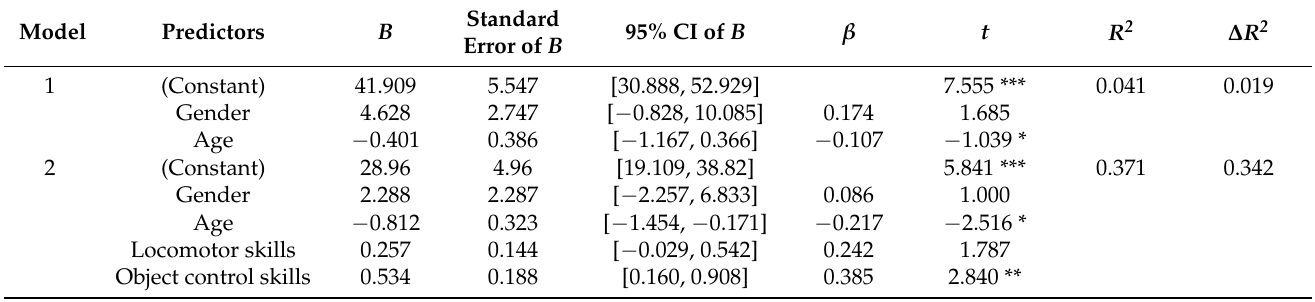
Table 6. Regression analysis results of participants’ FMS and average daily MVPA.